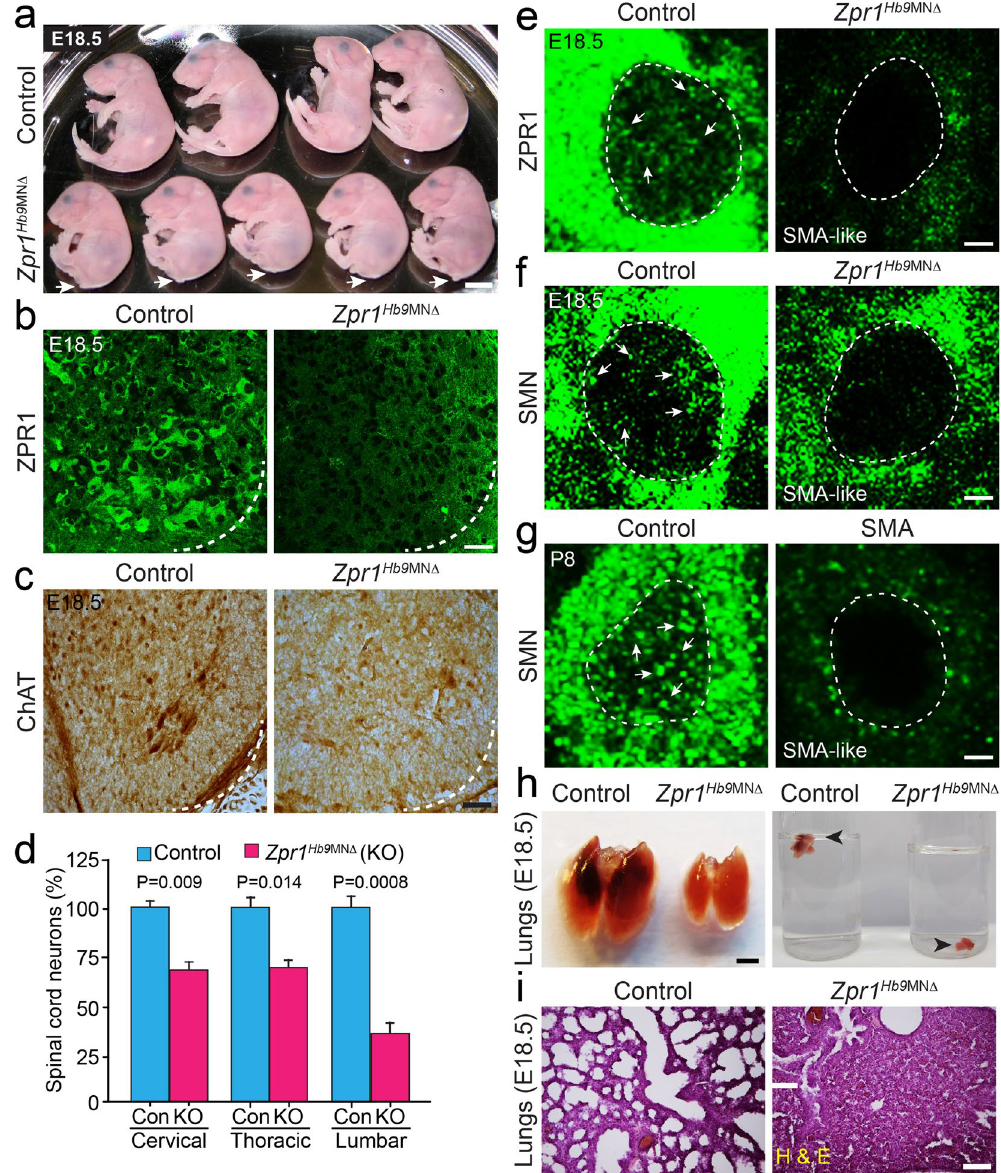
Figure 1. Mutation of the Zpr1 gene in motor neurons causes developmental defects and respiratory failure in Zpr1 Hb9 MN Δ mice. ( a ) Photograph of E18.5 control and Zpr1 Hb9 MN Δ embryos showing developmental defects in mutant embryos, including smaller size and loss of tail. Arrows indicate the absence of tail in mutant embryos. All mutant Zpr1 Hb9 MN Δ mice were cyanotic and dead at birth (stillbirth). Scale bar is 5 mm. ( b ) Spinal cord sections from the thoracic region (T9-T12) of E18.5 control and Zpr1 Hb9 MN Δ embryos were stained with monoclonal antibody against murine ZPR1 (Clone LG-D5). Zpr1 mutation in motor neurons results in reduced ZPR1 expression in spinal cord neurons of mutant embryos. Scale bar is 25 μ m. ( c ) ZPR1 deficiency in motor neurons results in the loss spinal cord neurons. Spinal cord sections stained with antibody against choline acetyl transferase (ChAT). Scale bar is 100 μ m. ( d ) Loss of neurons (mean ± s.e.m.; n = 3 mice/group) in different region of the spinal cords from Zpr1 Hb9 MN Δ embryos, cervical (31.96 ± 6.74%, p = 0.009), thoracic (30.52 ± 7.38%, p = 0.014) and lumbar (64.46 ± 7.10%, p = 0.0008) regions. ( e ) Zpr1 mutation causes reduction in the cytoplasmic and nuclear staining of ZPR1 and ( f ) SMN in spinal cord neurons and show SMA-like phenotype. ( g ) Spinal cord motor neurons from SMA mice show phenotype similar to Zpr1 Hb9 MN Δ mice. Arrows indicate accumulation of ZPR1 and SMN in sub-nuclear bodies in control neurons but sub-nuclear bodies missing in Zpr1 mutant and SMA mice. Dotted arcs represent the orientation of view from the anterior horn side of the spinal cord. Scale bar is 5 μ m. ( h ) Lungs from E18.5 Zpr1 Hb9 MN Δ embryos were smaller than control and lungs of Zpr1 Hb9 MN Δ embryos immediately sank in water, indicating lungs were not inflated with air. Scale bar is 2.5 mm. ( i ) Histological analysis shows defects in morphogenesis of lungs from Zpr1 Hb9 MN Δ embryos and lungs were collapsed. Scale bar is 200 μ